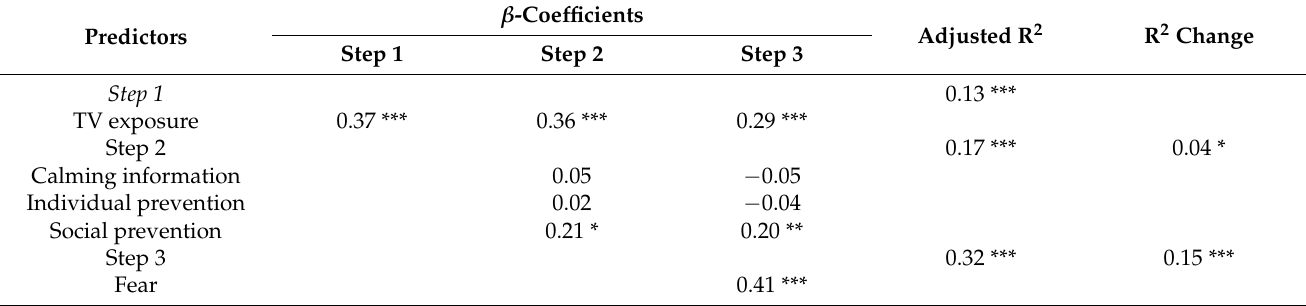
Table 2. Hierarchical multiple regression analysis: predictors of change in the use of public